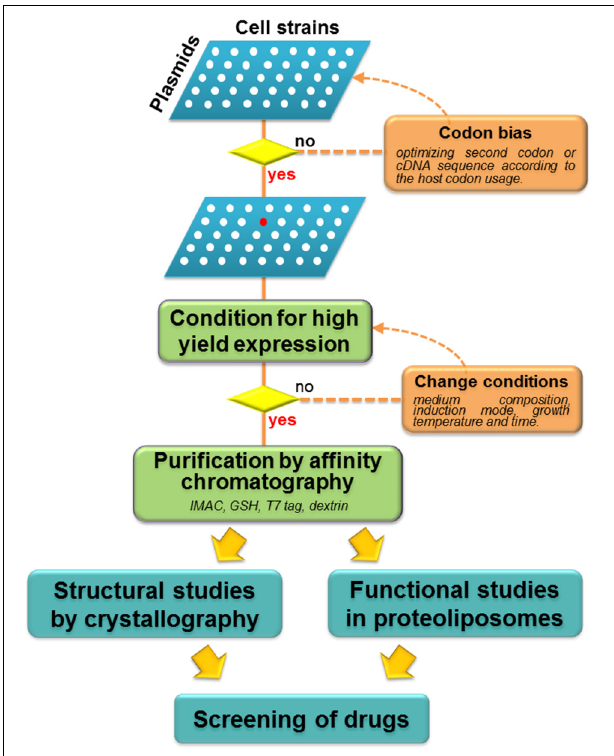
FIGURE 3 | Work flow of heterologous over-expression of membrane transporters. Schematic representation of screening of different combination Plasmid/Cell strains (white spots): if the attempts with wild type gene is not successful, codon bias strategy should be applied. Thus, selection of the best plasmid/cell strain combination is performed (red spot) with optimization of conditions for high yield expression. When this result is achieved, purification procedures are applied to perform both structural and functional studies. These strategies allow large scale screening of potential drugs or